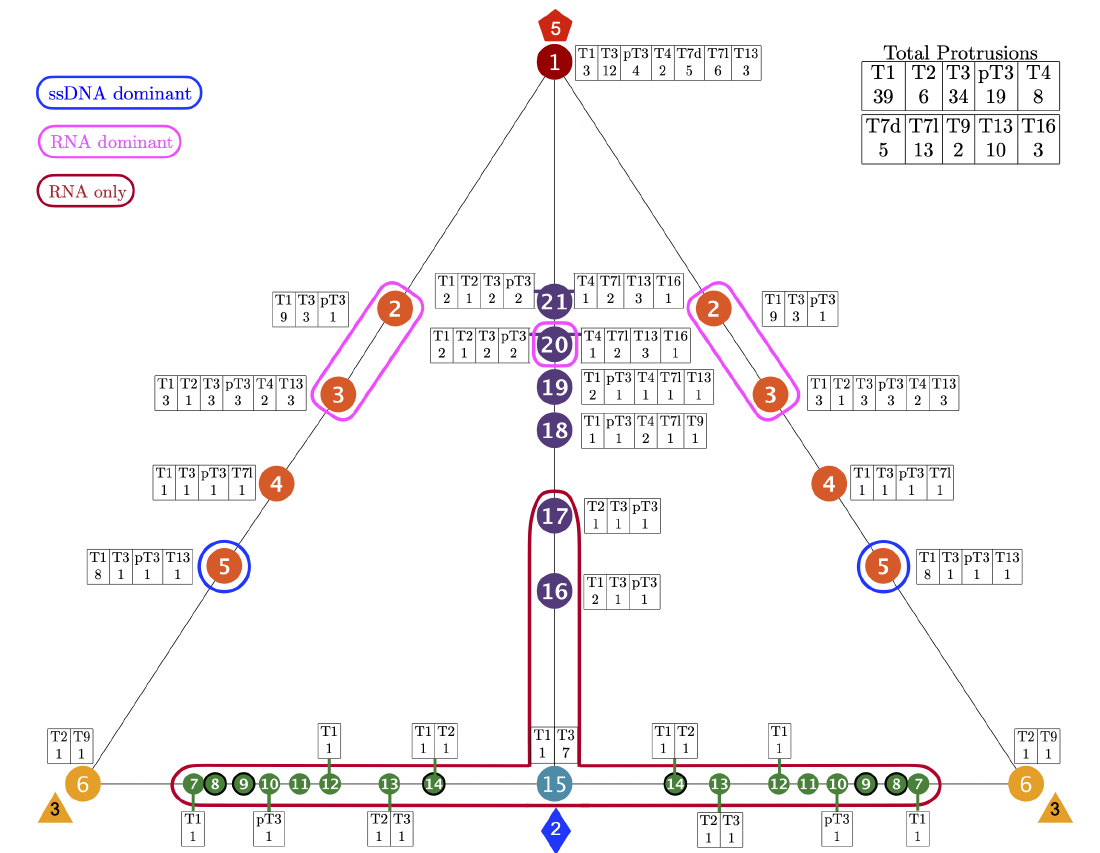
Figure 5. The 149 distinct structural protrusions and their corresponding T-numbers mapped onto the 21 unique gauge points of the Asymmetric unit (AU) [2]. The total number of protrusions for each T-number is shown in the upper right. The region encircled in red, GP 7 to GP 17 was found to only have RNA viruses with a T-number from 1 to 3. The regions encircles in pink (GP 2, 3 and 20) are dominated by RNA viruses (71% or more). Gauge point 5 is encircled in blue and primarily used by T1 capsid with ssDNA. The region between the 3-fold and 2-fold axes, GP 7 to 14 is not heavily used by any viruses. Overall, T-number is not strongly predicted by gauge point location. There are 10 viral protrusions belonging to T21 and larger capsids not shown here. All of these capsids used GP 1 or GP 21. The angular locations of the gauge points are shown to scale on a flat AU face. There is a sizeable gap between GP 1 and GP 2 and GP 21, as there is between GP 5 and GP